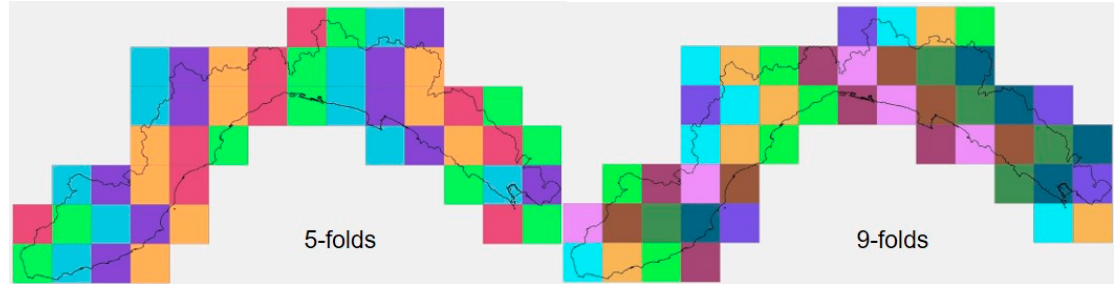
Figure 4. Spatial arrangement of the blocks for the 5- and 9-folds adopted in the work (each color corresponds to a single fold).